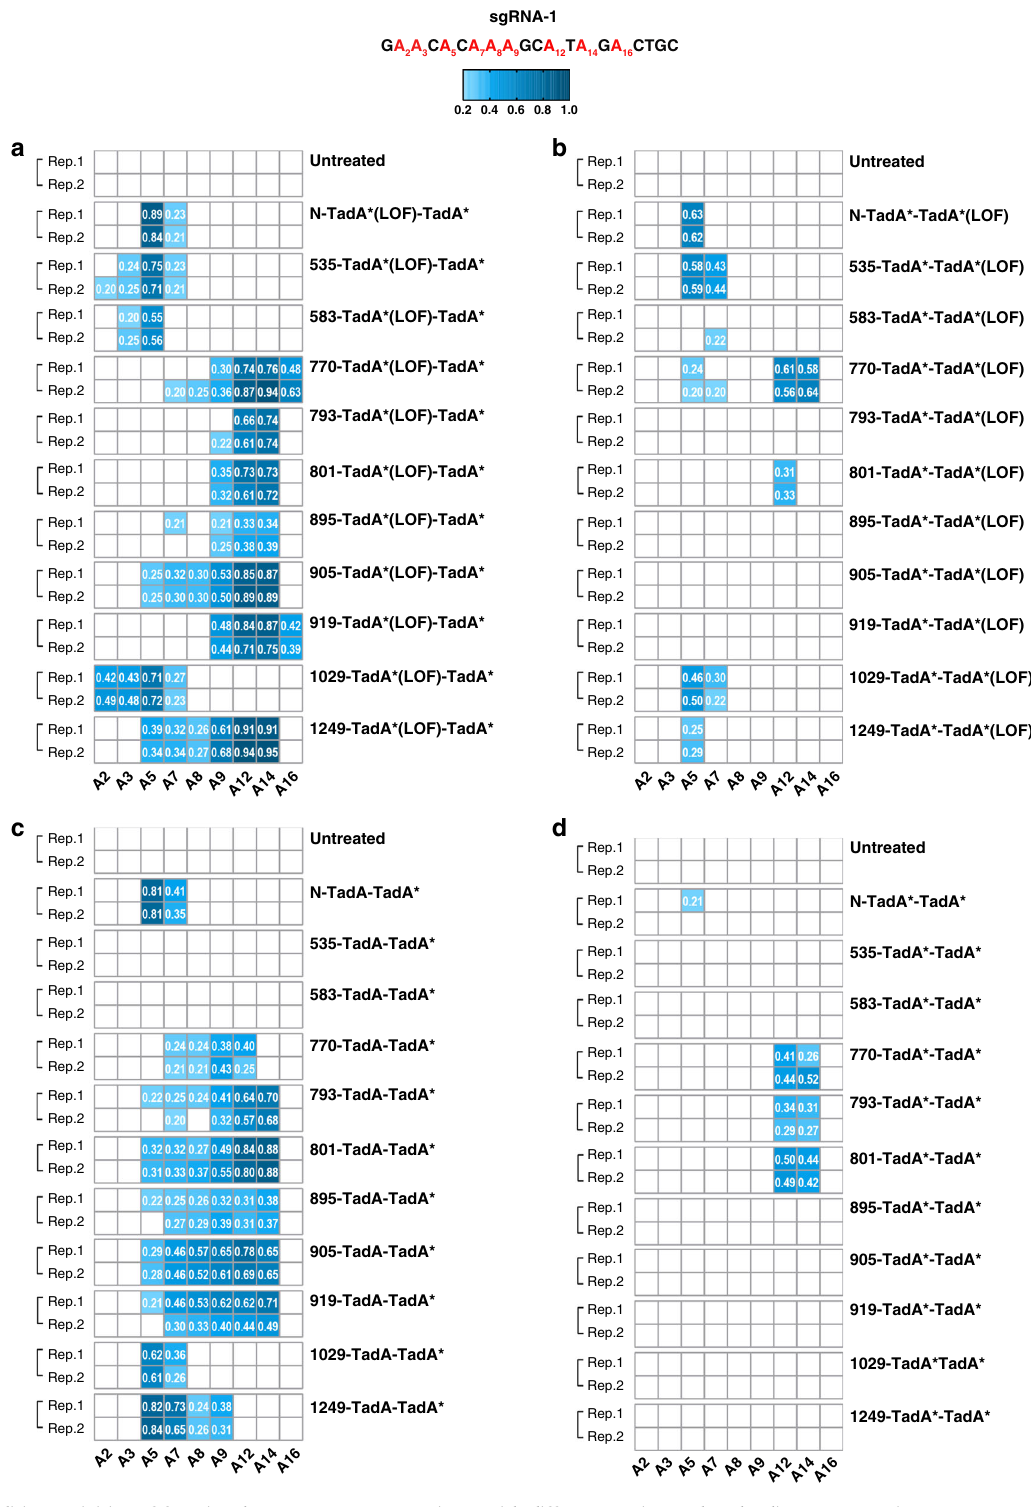
Fig. 2 Base editing activities of functional ABE-nSpCas9-DS variants with different engineered TadA dimers. Base editing activities of ABE (TadA* (LOF)-TadA*)-nSpCas9-DS variants ( a ), ABE (TadA*-TadA* (LOF))-nSpCas9-DS variants ( b ), ABE (TadA-TadA*)-nSpCas9-DS variants ( c ), and ABE (TadA*-TadA)-nSpCas9-DS variants ( d ) against sgRNA-1 were shown in heat map. Adenines in sgRNA-1 were labeled as red. A – G conversion frequencies at every adenine nucleotide in 20 bp protospacer were quanti fi ed with EditR. Two independent experiments were performed and editing frequencies >0.20 were labeled in the heat map. Source data are available in the Source data fi